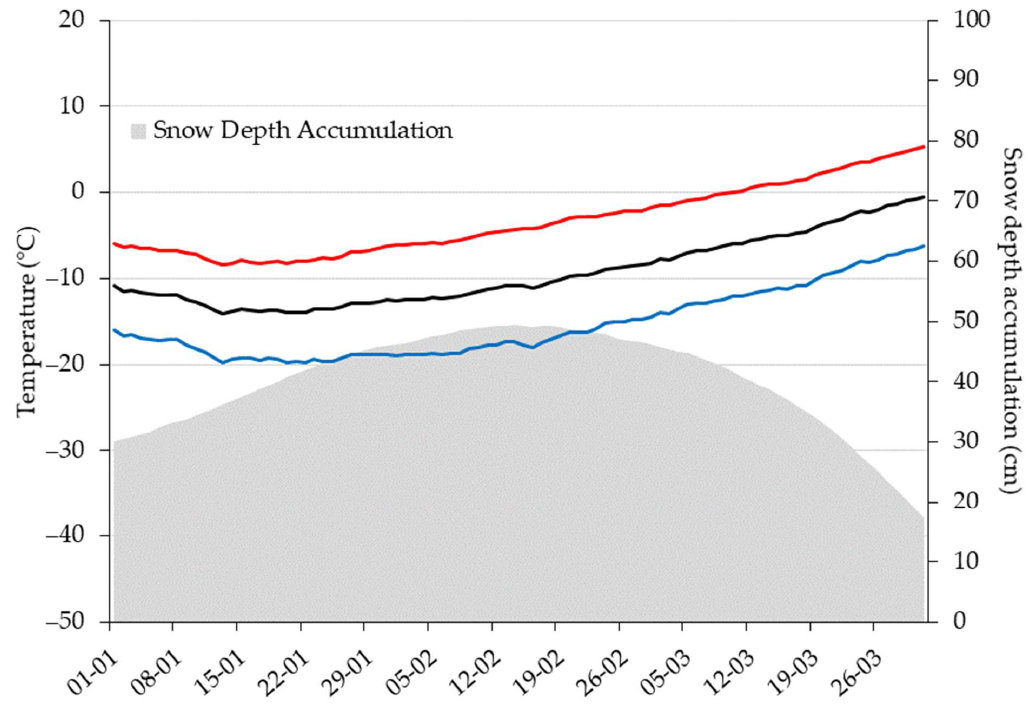
Figure 2. Variation of maximum (red), mean (black), and minimum (blue) daily air temperatures (January-March) for climatic normals (1991–2020) at the Grandes-Piles forest nursery (Québec, QC, Canada). The areas in gray indicate snow depth accumulation.